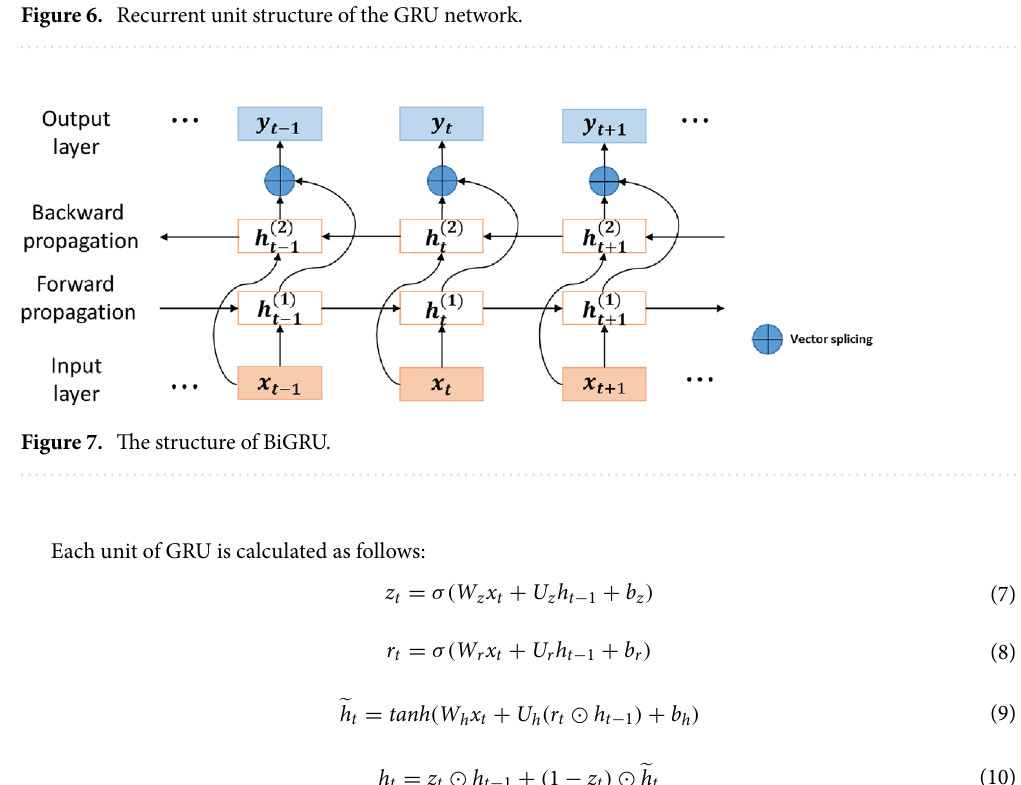
Figure 6. Recurrent unit structure of the GRU network.